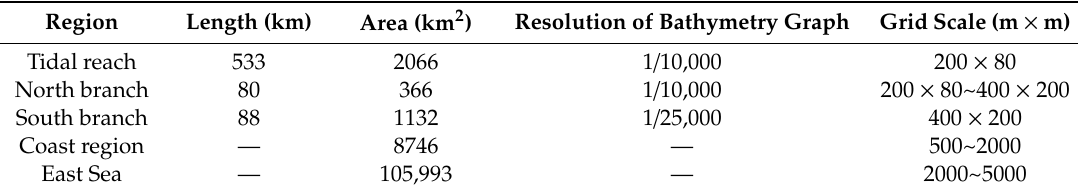
Table 1. Grid scales of high-resolution unstructured grids in Yangtze